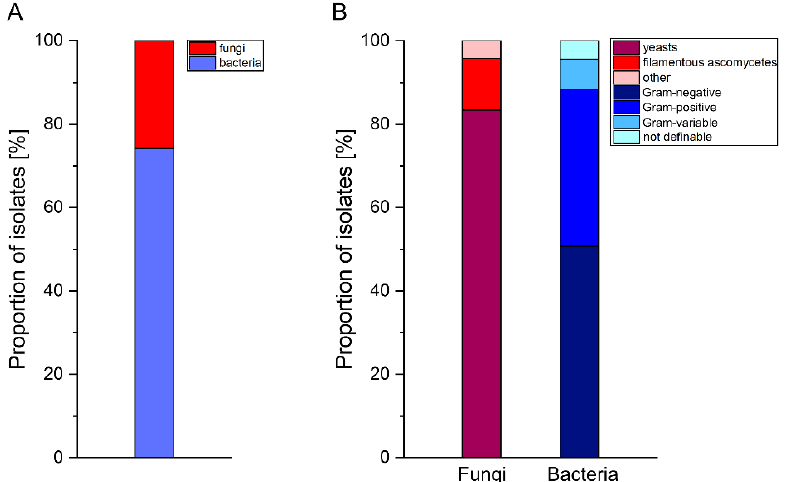
Figure 1. Superordinate categorization of the isolates. ( A ) Ratio of fungal and bacterial isolates. ( B ) left: Distribution of filamentous and yeast-like fungi. ‘Other’ describes a single member of the Mucoromycota . right: Bacterial community classification based on Gram staining characteristics.